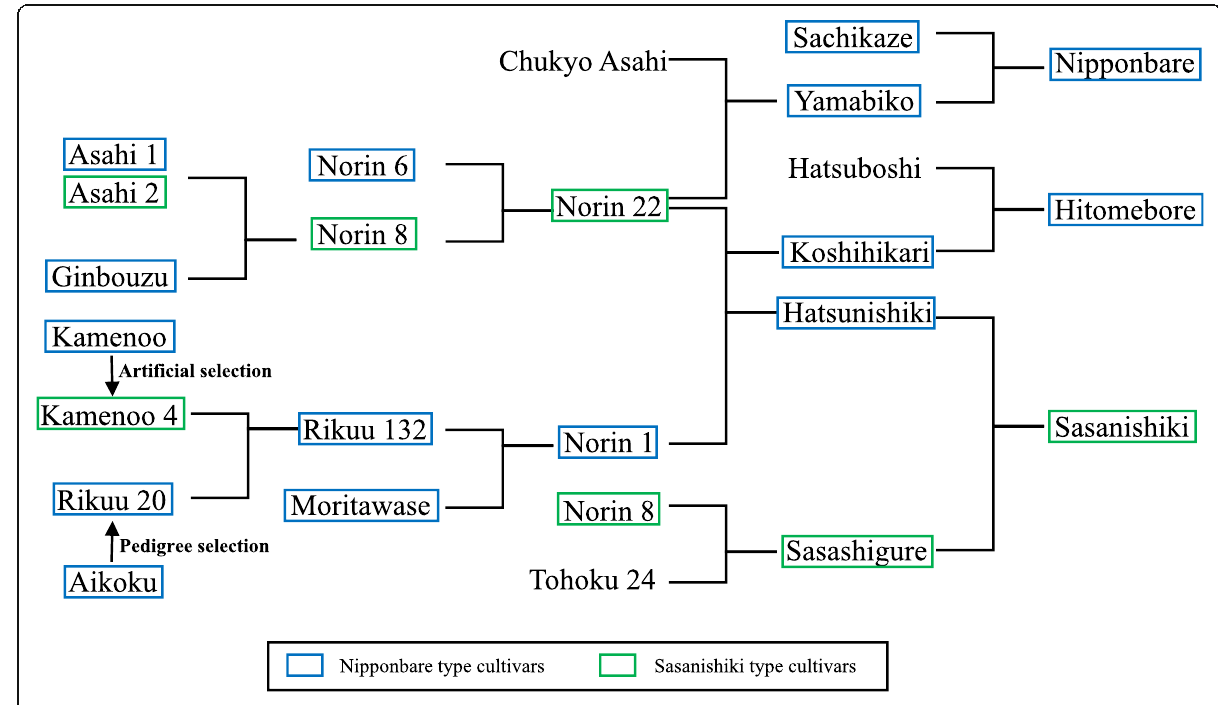
Fig. 2 The breeding history of modern O. sativa ssp. japonica cultivars Nipponbare, Hitomebore, and Sasanishiki was obtained from Agriknowledge database (https://agriknowledge.affrc.go.jp/). The modern rice breeding in Japan was from Norin